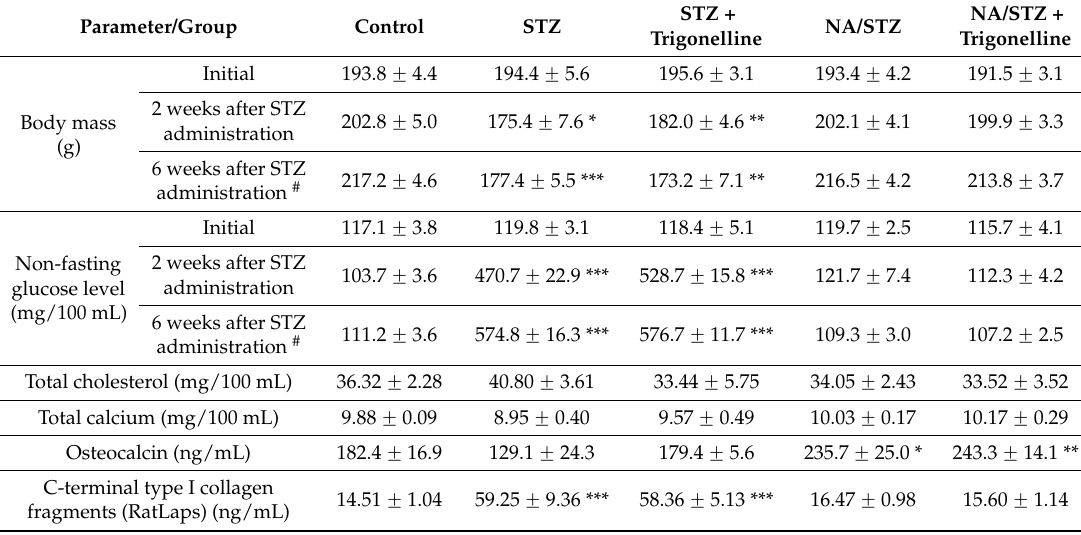
Table 1. Effect of trigonelline (50 mg/kg p.o. for four weeks) on the general parameters and bone turnover markers in rats treated with streptozotocin (STZ) or nicotinamide and streptozotocin